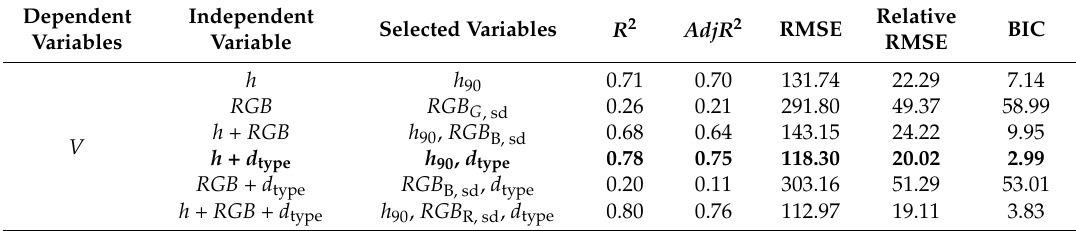
Table 3. Summary of the selected estimation models for four forest biophysical properties: stand model for each biophysical